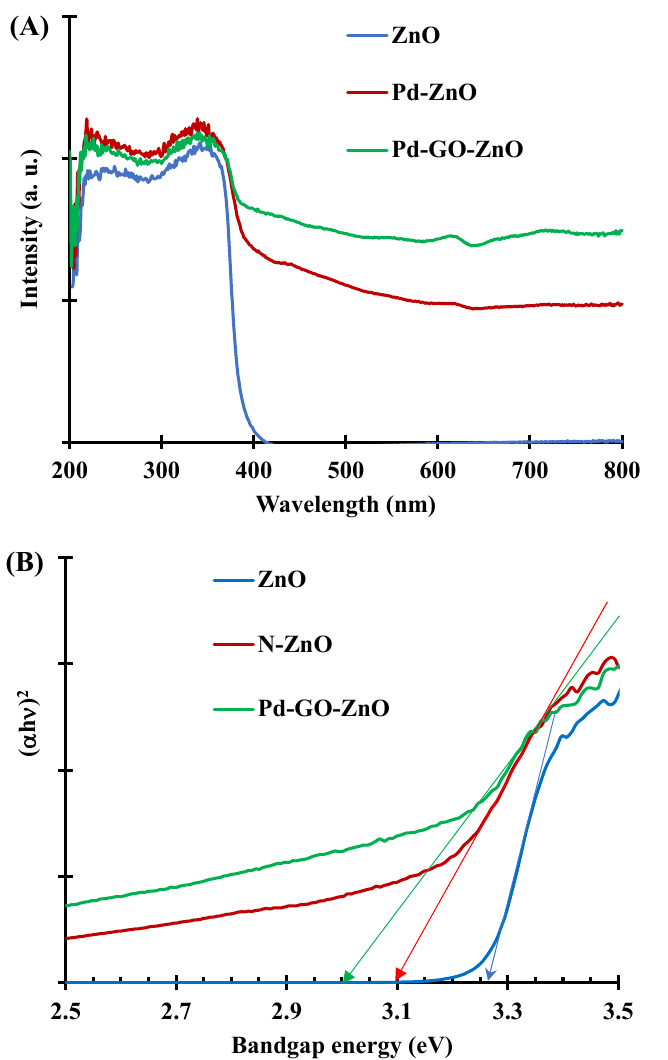
Figure 5. ( A ) UV–vis spectra and ( B ) estimated bandgap energies from the Tauc plots.